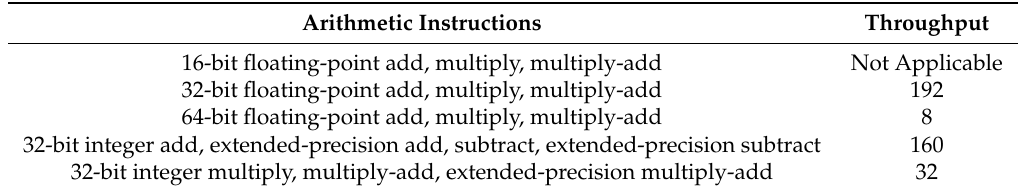
Table 2. Number of Operations per Clock Cycle per